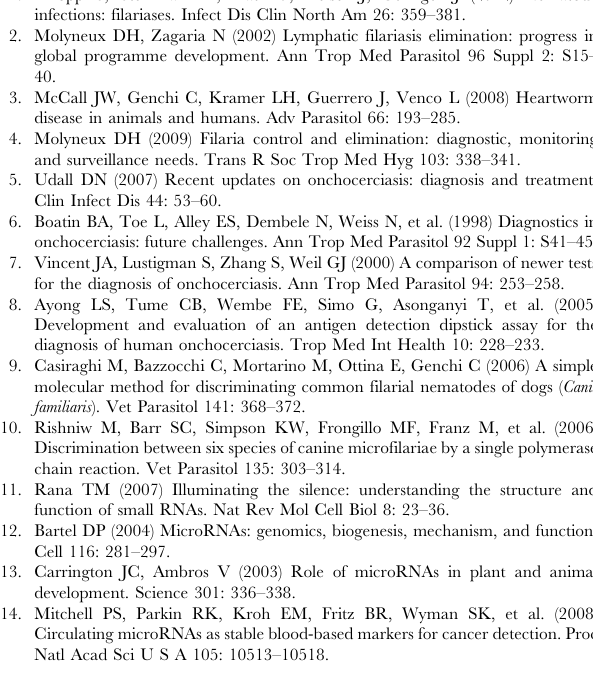
Table S1 Dog miRNA candidate sequences identified by deep- sequencing. Table S2 Dirofilaria immitis miRNA candidate sequences identi-